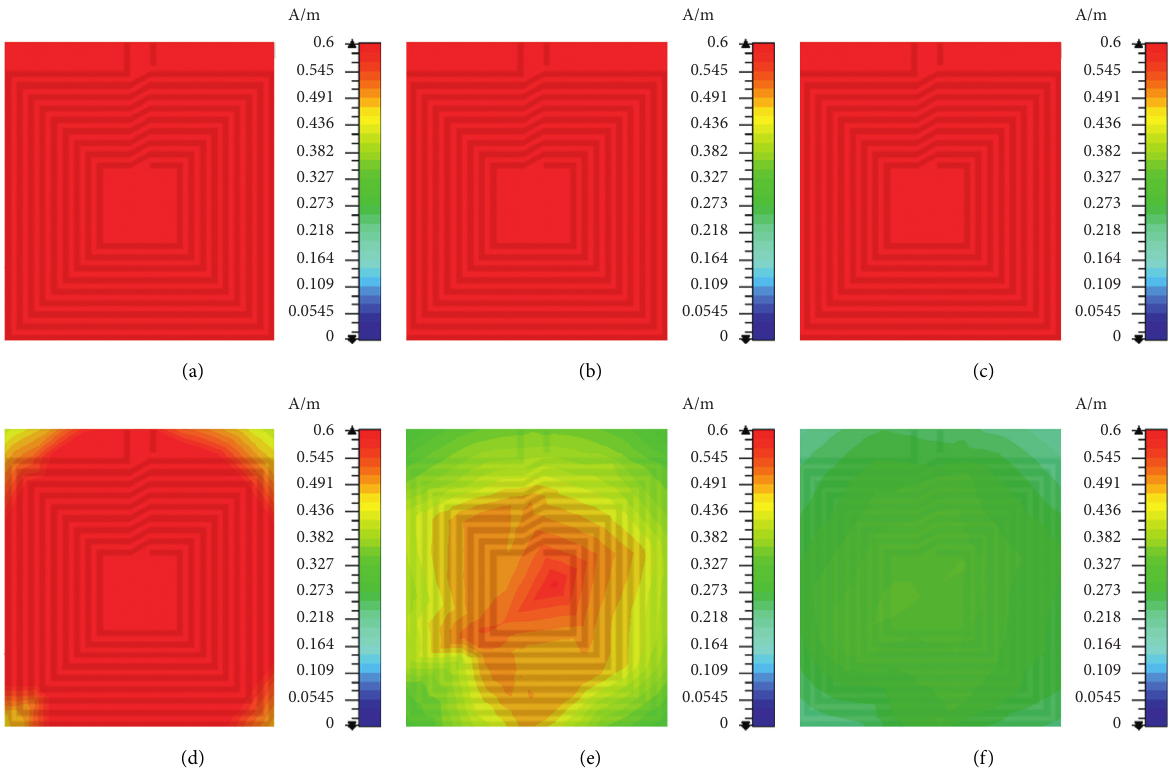
Figure 3: The simulated total magnetic fields of HF-RFID square spiral structure when varying distance. (a) 0cm, (b) 2cm, (c) 3cm, (d) 4cm, (e) 5cm, and (f)